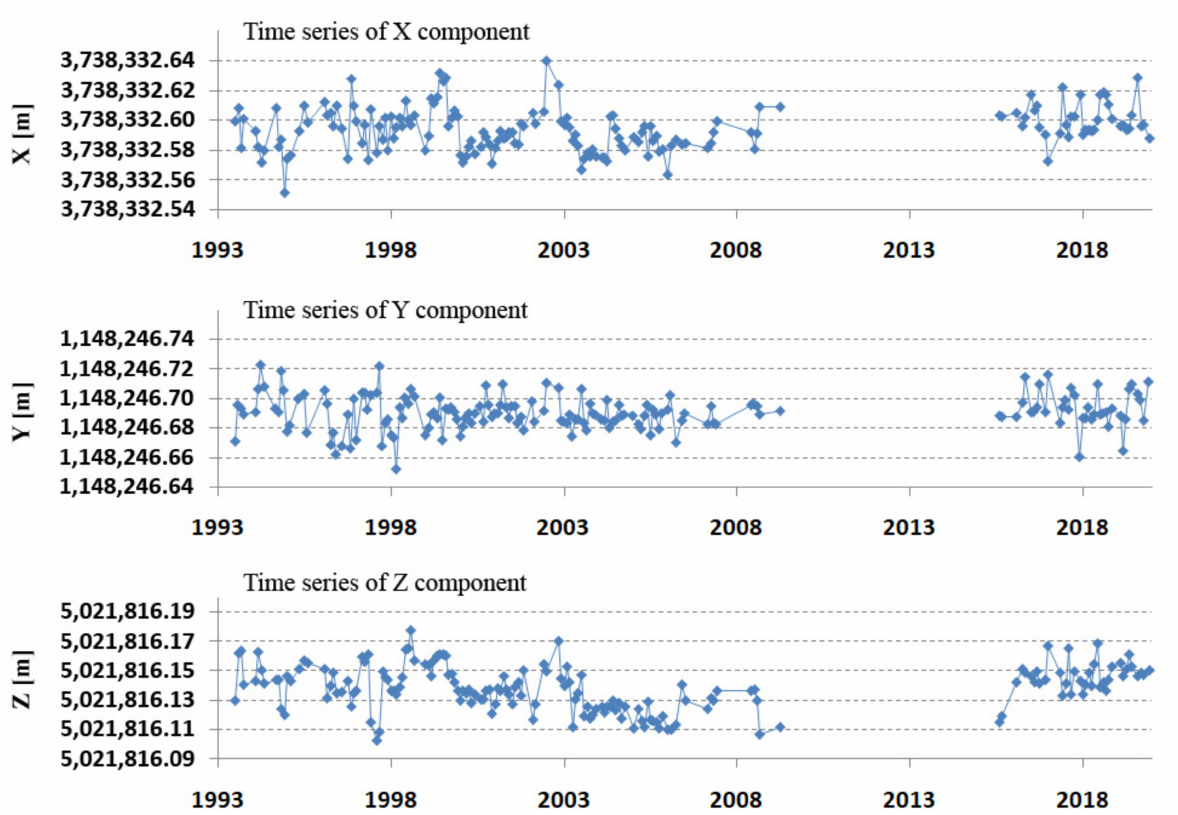
Figure 7. Borowiec SLR station—de-trended for epoch 2010.0 geocentric coordinates X, Y, Z (m) in 1993–2019. Table 5. Average geocentric coordinates X, Y, Z of the Borowiec SLR station for each period. X Period [m]